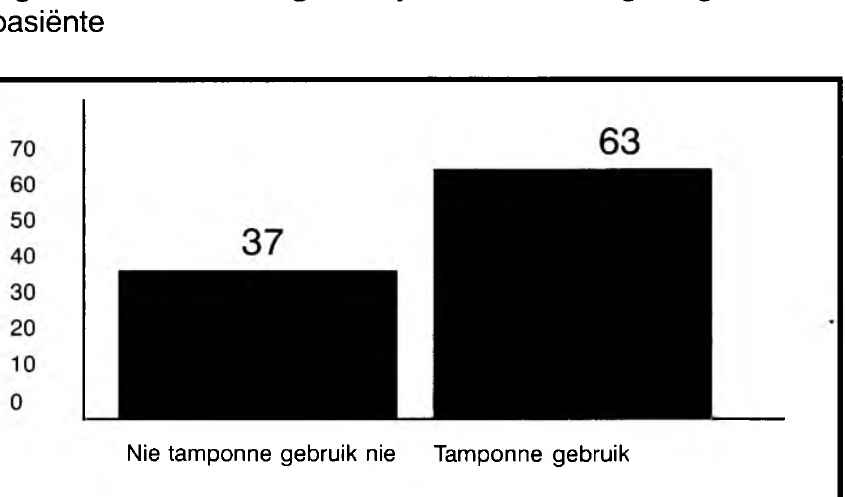
Figuur 1 : Sanitêre higiëne by endometrïose gediagnoseerde